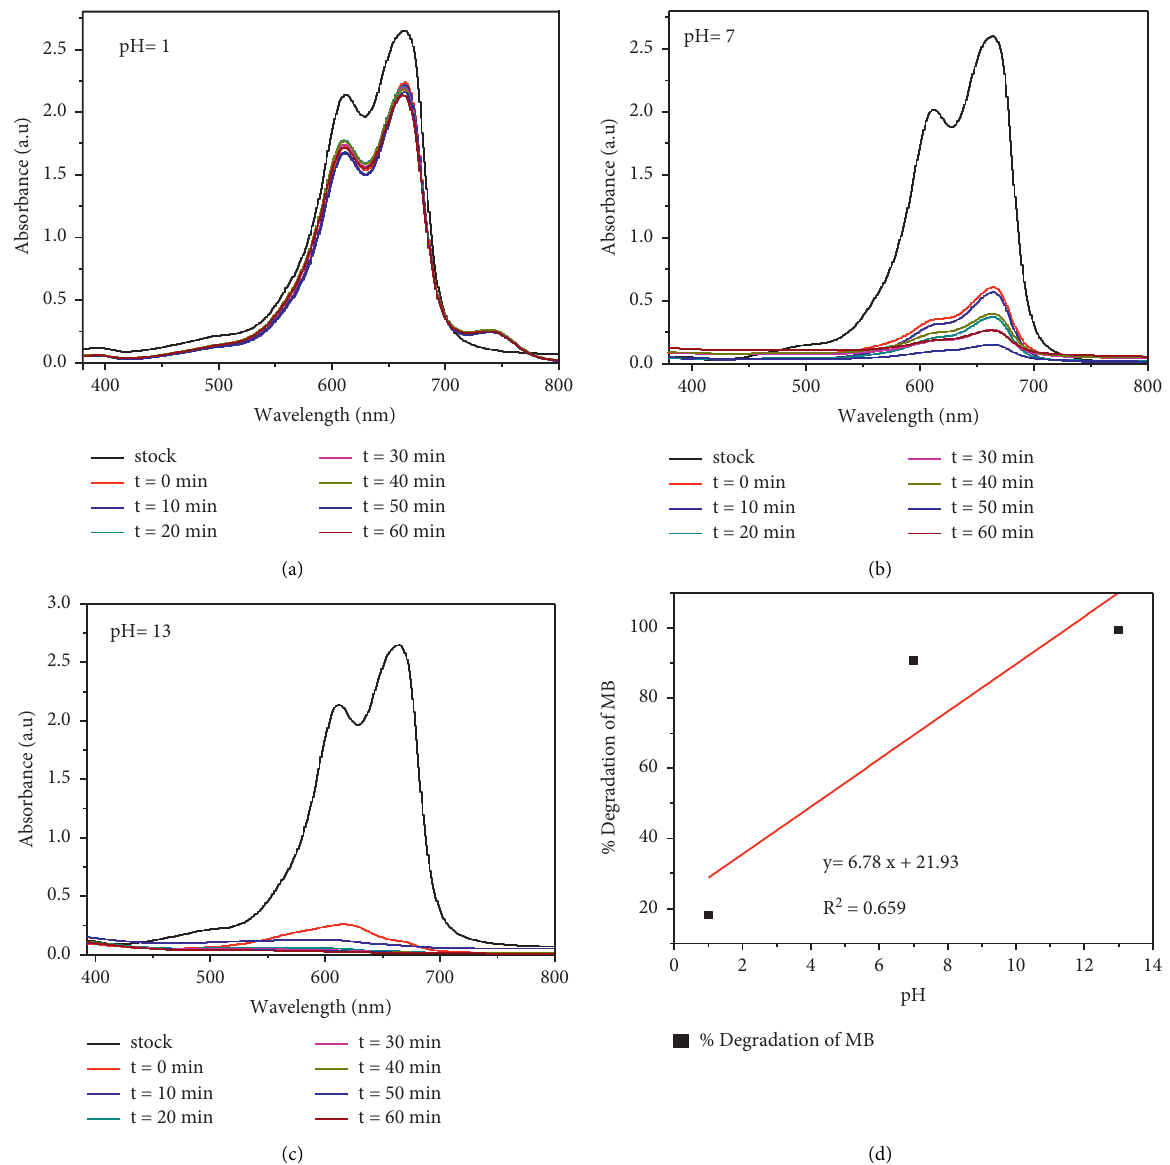
Figure 11: Effect of pH (a–c) and % of degradation (d) on the photocatalytic degradation of MB in the presence of TiO